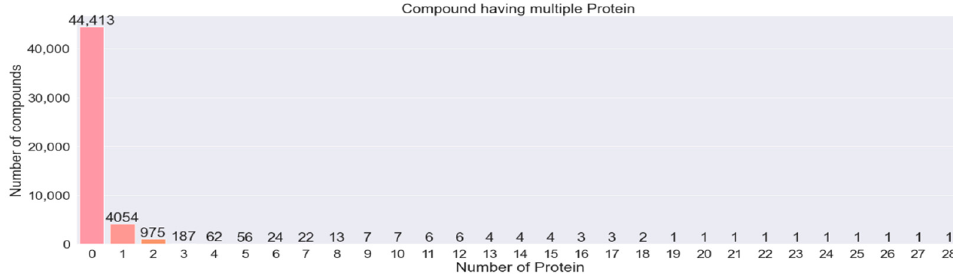
Figure 2. Details of the number of compounds that interact with at least one protein.